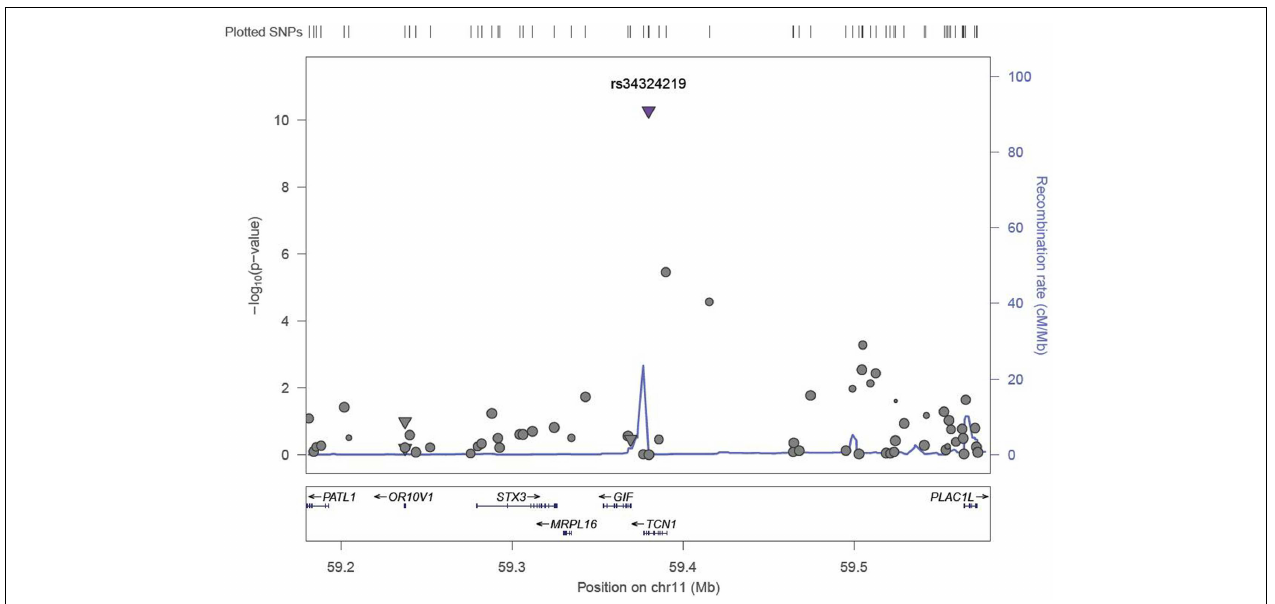
FIGURE 2 | LocusZoom association plot for single SNP associations withVitamin B 12 at the TCN1 locus .The SNP position and -LOG ( P -value) are plotted on the X and Y axis, respectively.